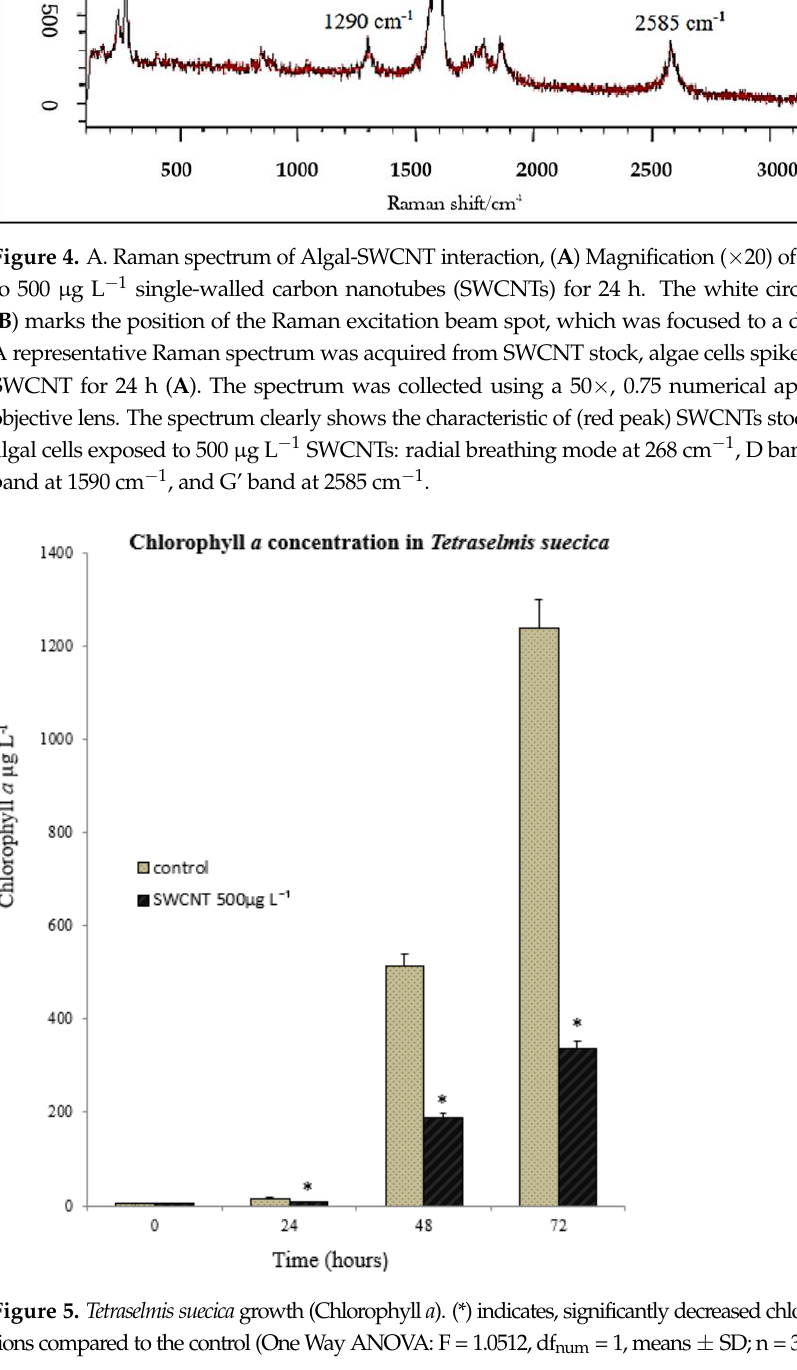
Figure 5. Tetraselmis suecica growth (Chlorophyll a ). (*) indicates, significantly decreased chlorophyll a concentra- tions compared to the control (One Way ANOVA: F = 1.0512, df num = 1, means ± SD; n = 3; p <